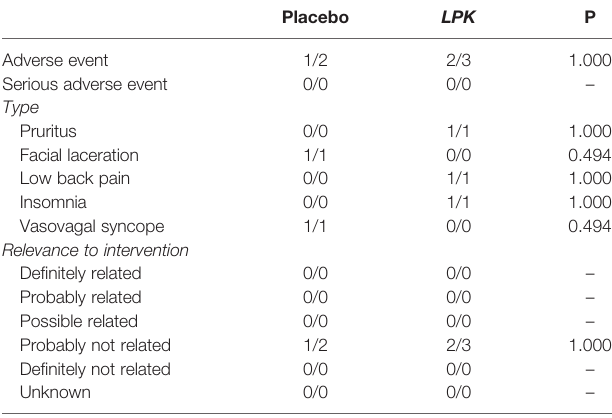
TABLE 4 | Adverse events.